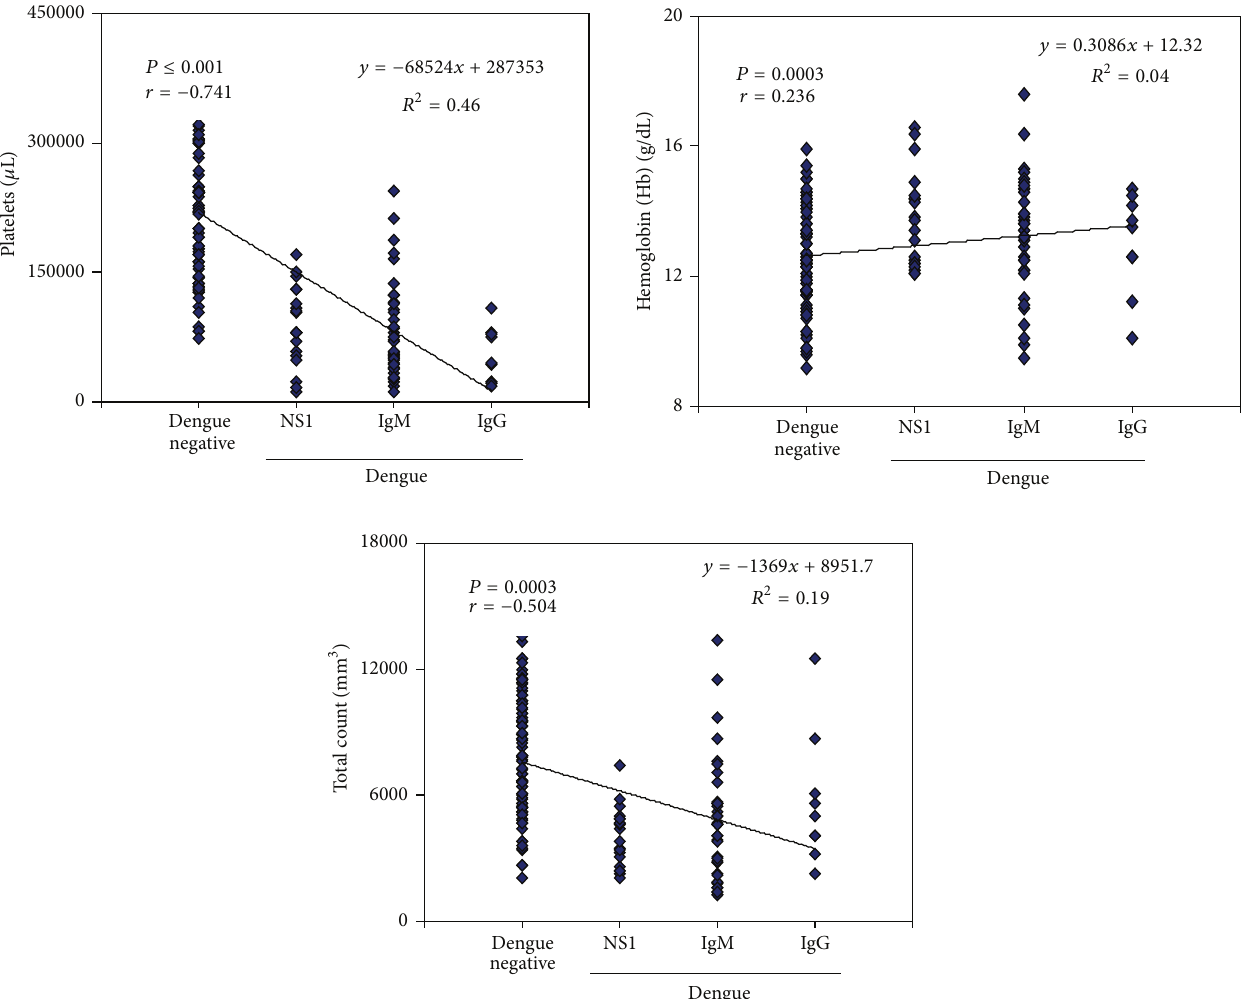
Figure 1: Association of platelets, haemoglobin, and total count with dengue negative, NS1, IgG, and